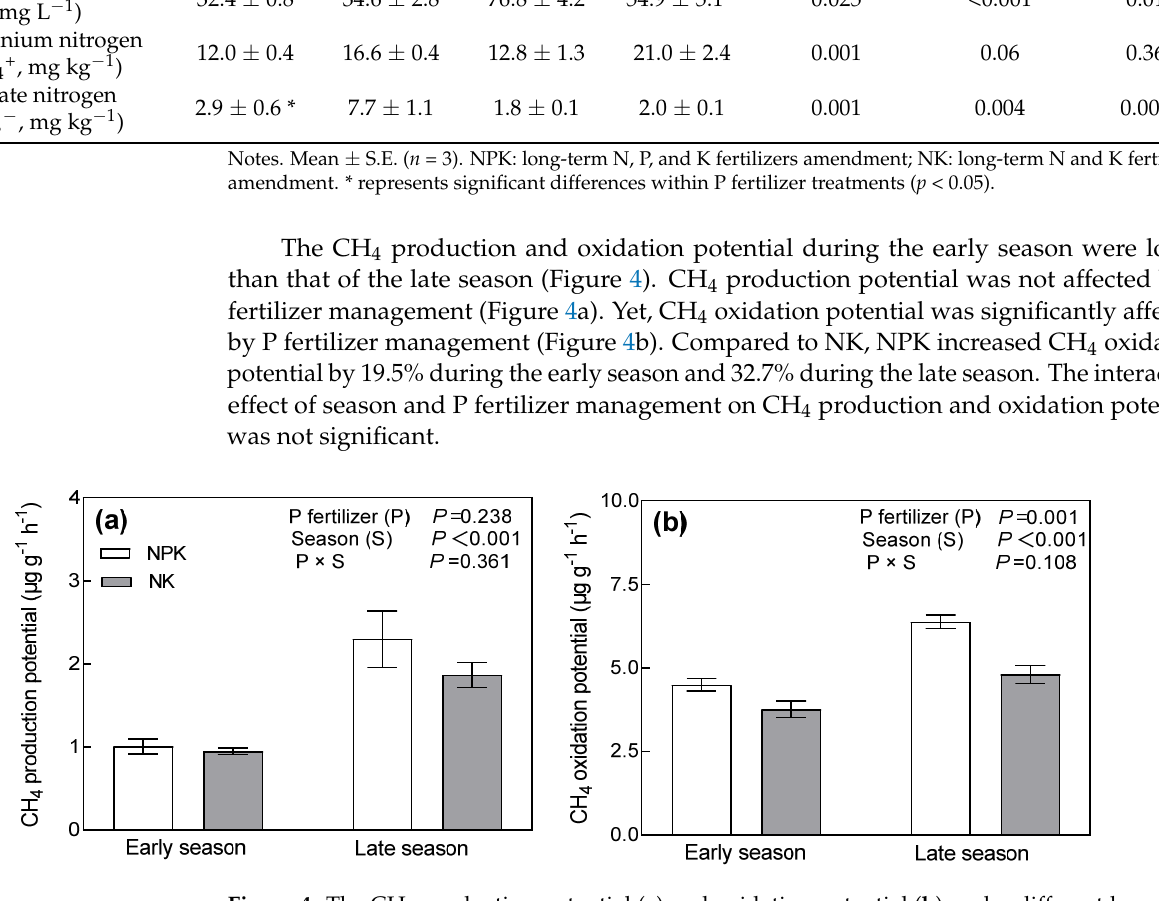
Figure 4. The CH 4 production potential ( a ) and oxidation potential ( b ) under different long-term P addition treatments during early and late rice seasons. NPK: long-term N, P, and K fertilizers application; NK: long-term N and K fertilizers application. Error bars represent S.E. ( n = 3).